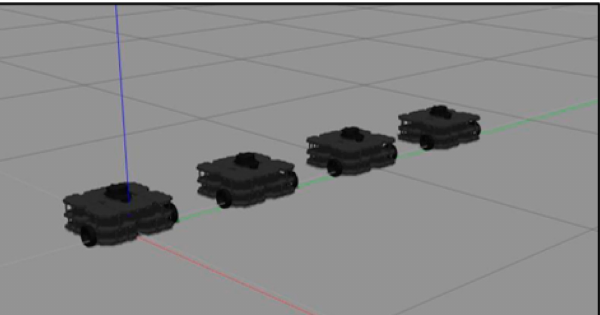
Figure 4. Gazebo 7 of the Open Source Robotics Foundation, used in simulations with four Turtlebot3 ® Waffle Pi robots aligned at the beginning of the test. The red, green, and blue lines indicate the X , Y , and Z axes, respectively.